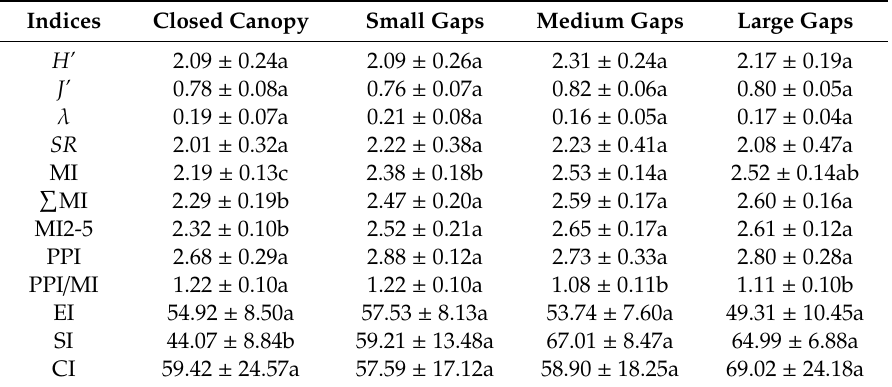
Table 3. Soil nematode community indices of the four treatments.